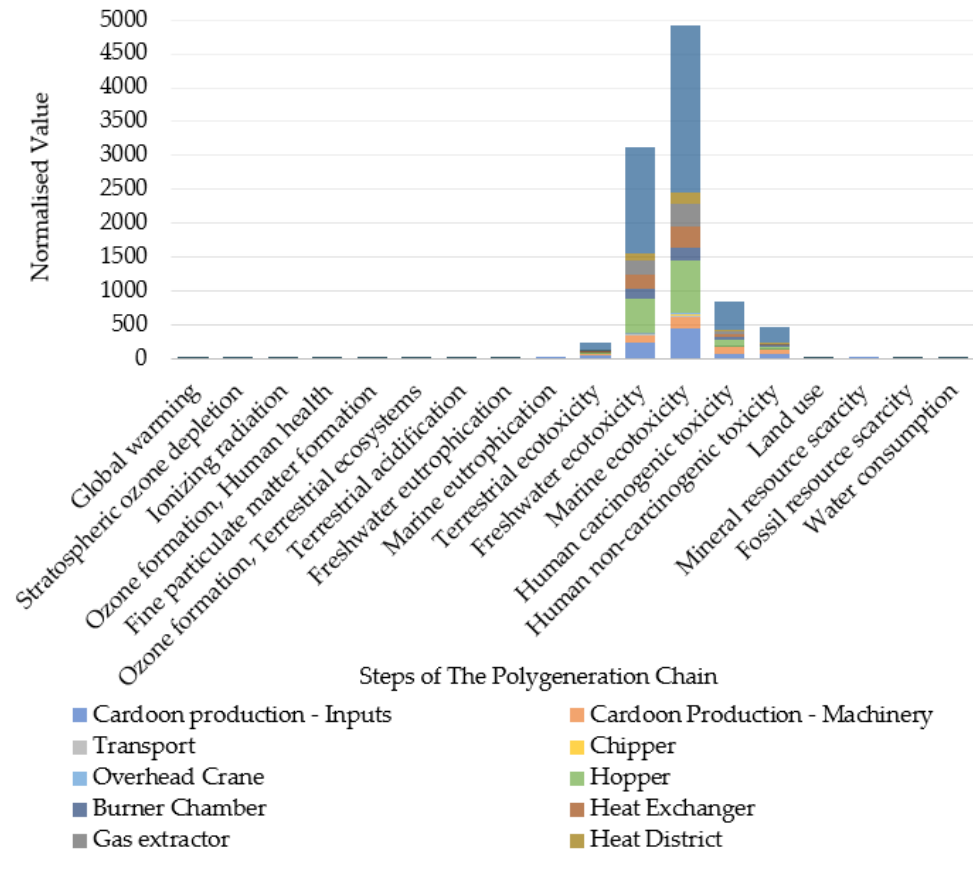
Figure 4. ReCiPe midpoint—normalised—polygeneration chain.